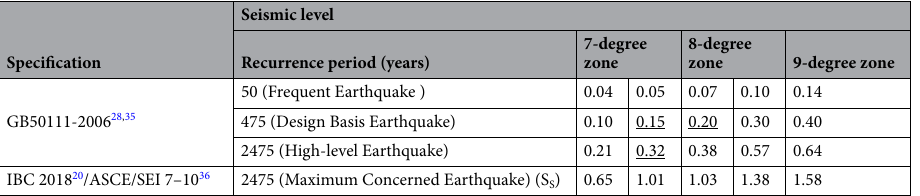
Table 4. Earthquake intensity of different seismic zones for different seismic codes (g). The values underlined are the input accelerations for the shaking table tests.